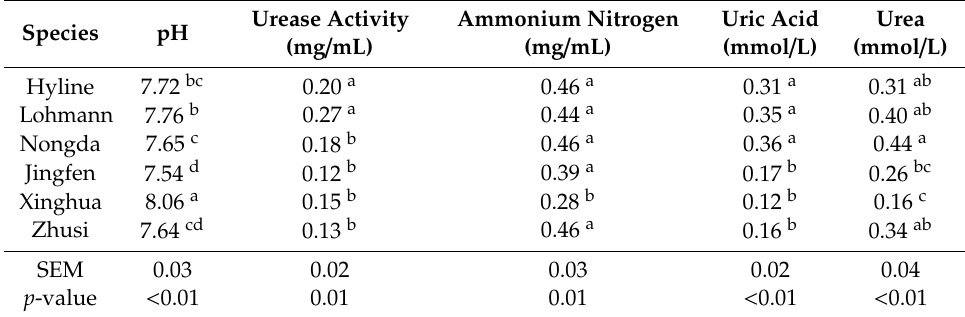
Table 4. The biochemical caecal parameters of six species of laying hen ( n = 5).